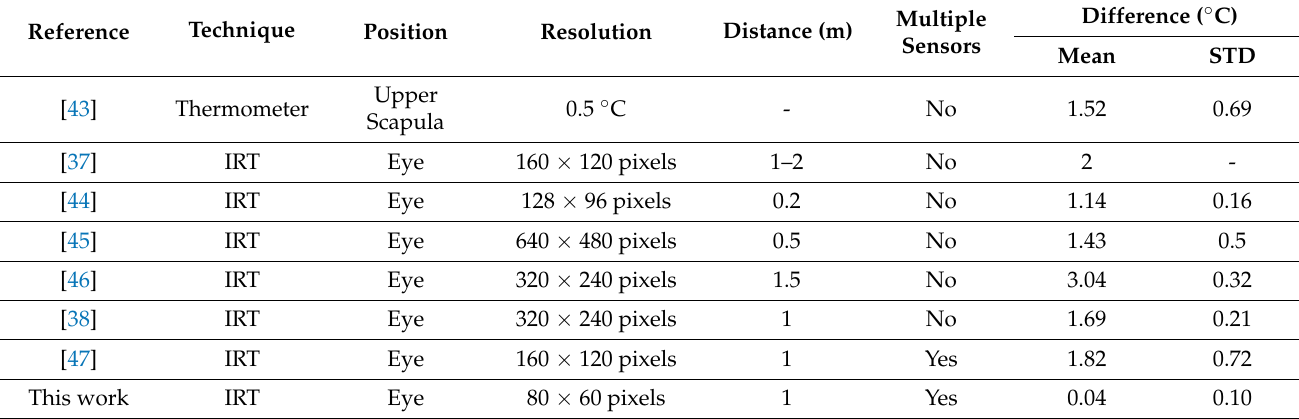
Table 2. Comparison of the measurement of cattle’s body temperature using different